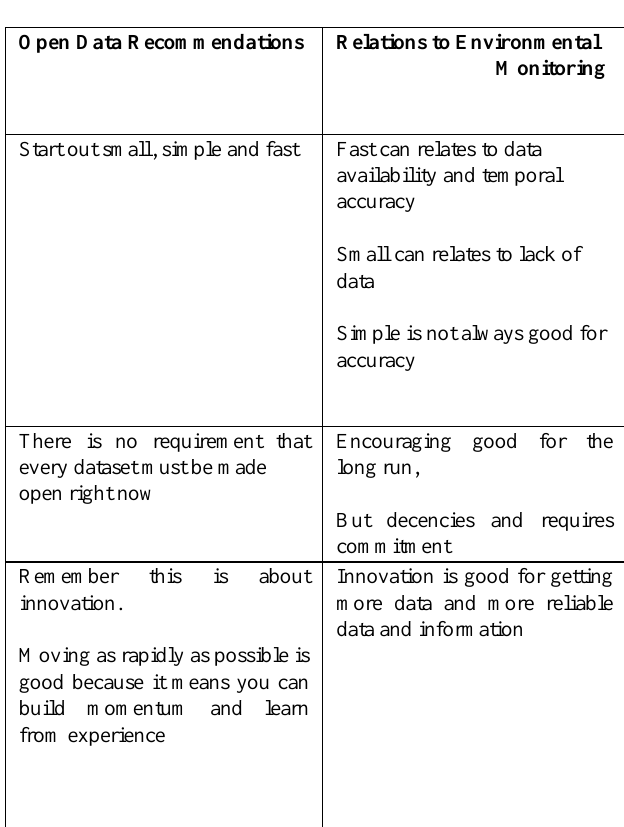
Table 1. Rules of OGD working